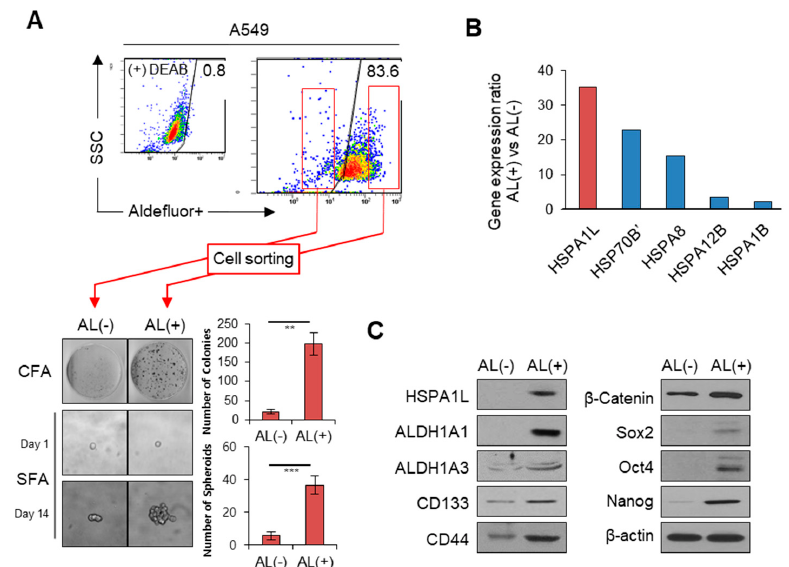
Figure 1. HSPA1L was highly upregulated in ALDH1high cells sorted from A549 cells. ( A ) ADLH1high and ALDH1low subpopulations sorted from A549 cells using ALDEFLUOR. An aliquot of ALDEFLUOR-exposed cells was quenched immediately with the specific ALDH1 inhibitor, diethylaminobenzaldehyde, as the negative control (upper panel). Colony-forming and single-cell sphere-forming assays in ALDH1low (AL − ) and ALDH1high (AL + ) (lower panel). ( B ) Heat shock protein members di ff ering more than two-fold in gene expression between ALDH1low (AL − ) and ALDH1high (AL + ). ( C ) Western blot analysis of HSPA1L and CSC markers in ALDH1high and ALDH1low cells. Data represent the mean ± SD of three independent experiments using a two-tailed t-test. ** p < 0.005, *** p < 0.001.